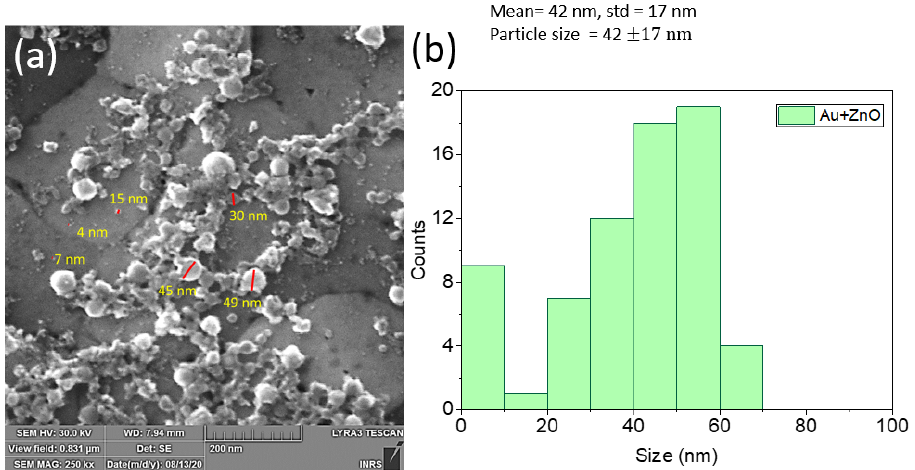
Figure 3. ( a ) SEM image and ( b ) particle size distribution of the Au + ZnO nanoparticles grown by PLAL.